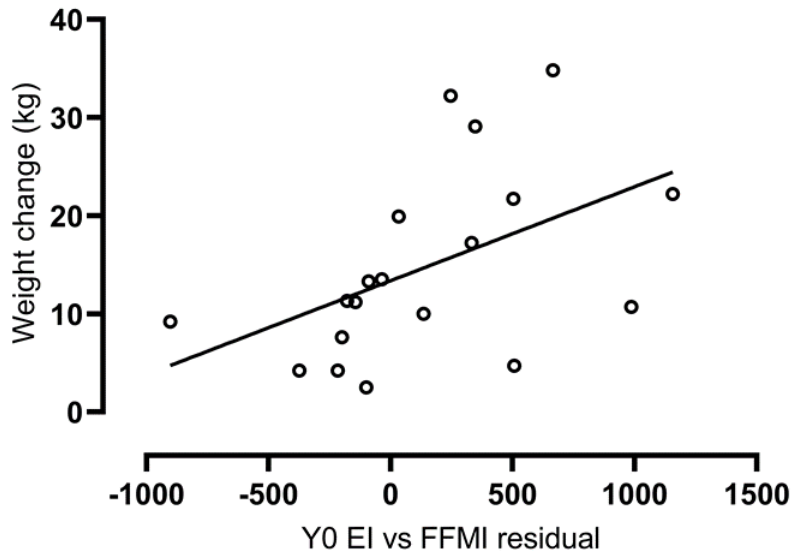
Figure 3. Association between energy intake (adj. for FFMI) at Baseline and weight change (kg) from Baseline to Year 2 (r = 0.49, p = 0.04). Abbreviations: energy intake, EI; fat-free mass index, FFMI; baseline, Y0.